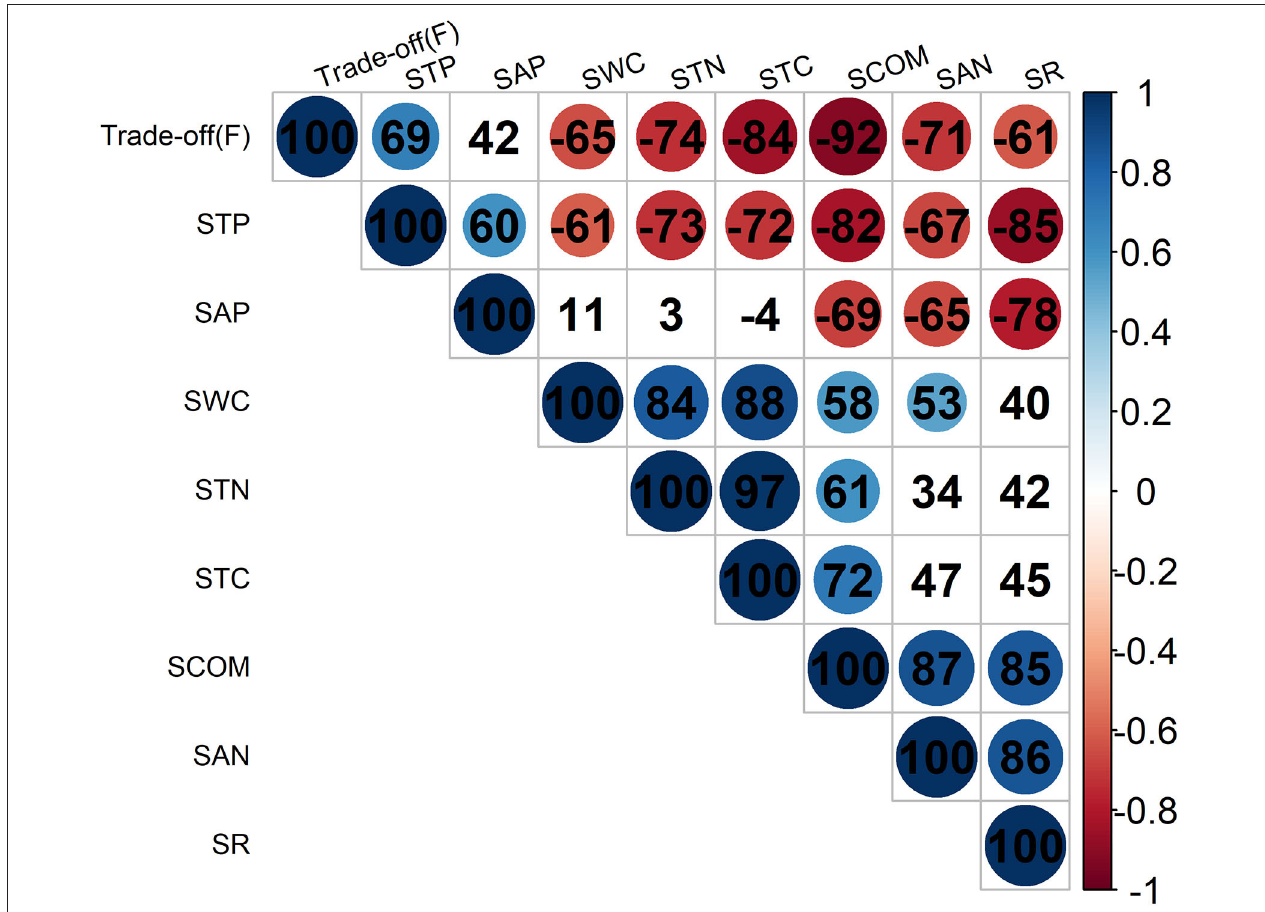
FIGURE 6 | Relationships of trade-off value of aboveground biomass of forbs [Trade-off(F)] with soil properties at 0–30cm soil depth (STC, STN, SAN, STP, SAP, SCOM, and SWC represent soil total carbon, soil total nitrogen, soil available nitrogen, soil total phosphorus, soil available phosphorus, soil compactness, and soil water content, respectively), and species richness (SR). The highlighted colored solid circles indicate significant correlations between variables at 0.05